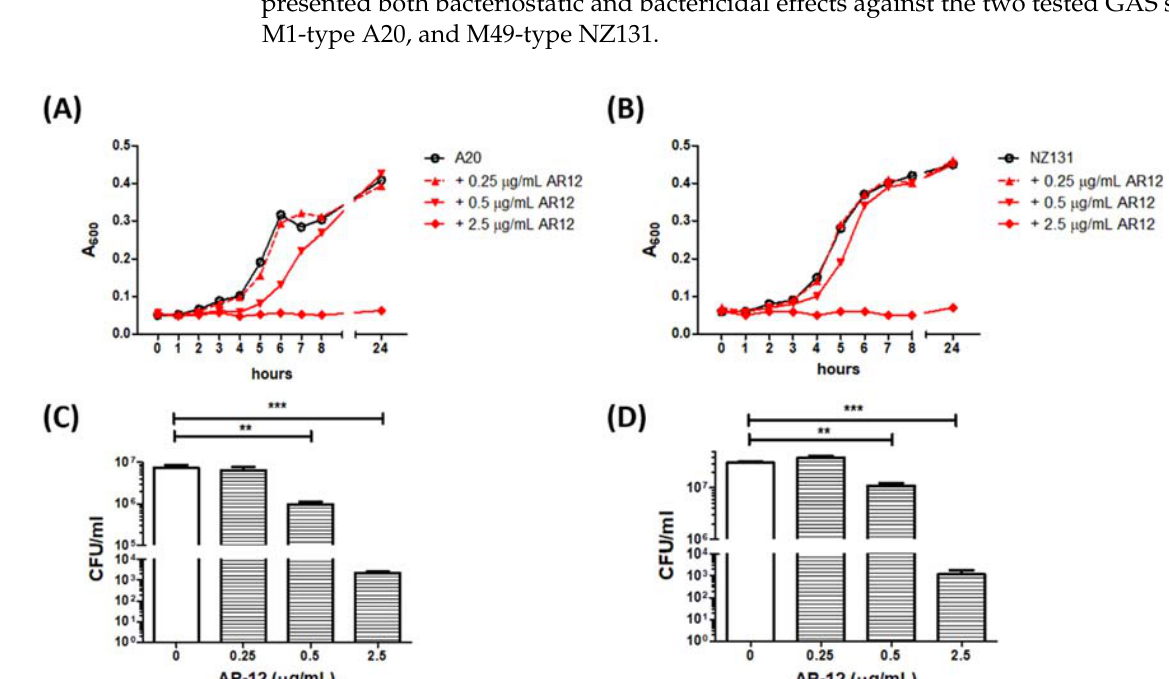
Figure 1. AR-12 inhibited growth of group A Streptococcus in vitro. The M1-type GAS A20 strain ( A , C ) or the M49-type GAS NZ131 strain ( B , D ) was cultured in THY medium with different concentrations of AR-12. The growth curve of GAS after AR-12 treatment on both GAS strains was estimated by spectrophotometry ( A , B ) and by CFU-based assay ( C , D ). The turbidity of the bacteria was determined with a spectrophotometer by measuring the absorbance at 600 nm (A 600 ). The number of remaining bacteria in each group after 2 h cultivation of AR-12 was quantified by plating on THY agar plates. Treatment groups were compared for significance using ANOVA. ** p < 0.01, *** p < 0.001 compared with the relative groups as shown in the figure.